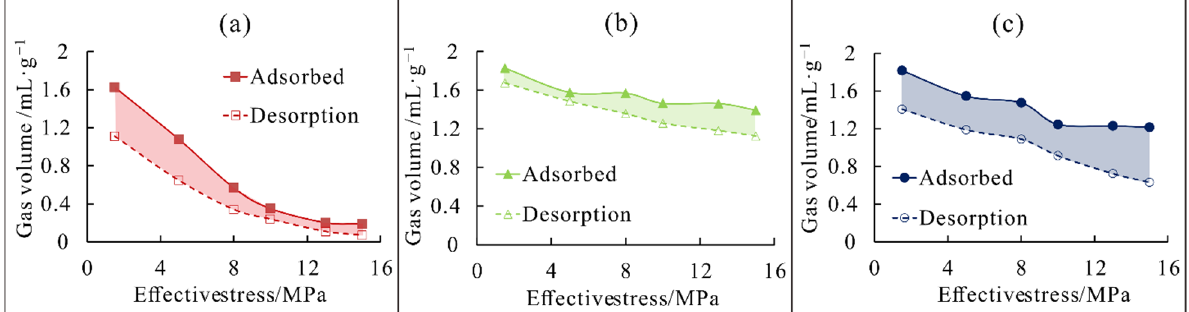
Figure 9. Change of adsorption/desorption gas volume with effective stress: ( a ) is the PUC sample; ( b ) is the BDC sample; ( c ) is the DDC sample.